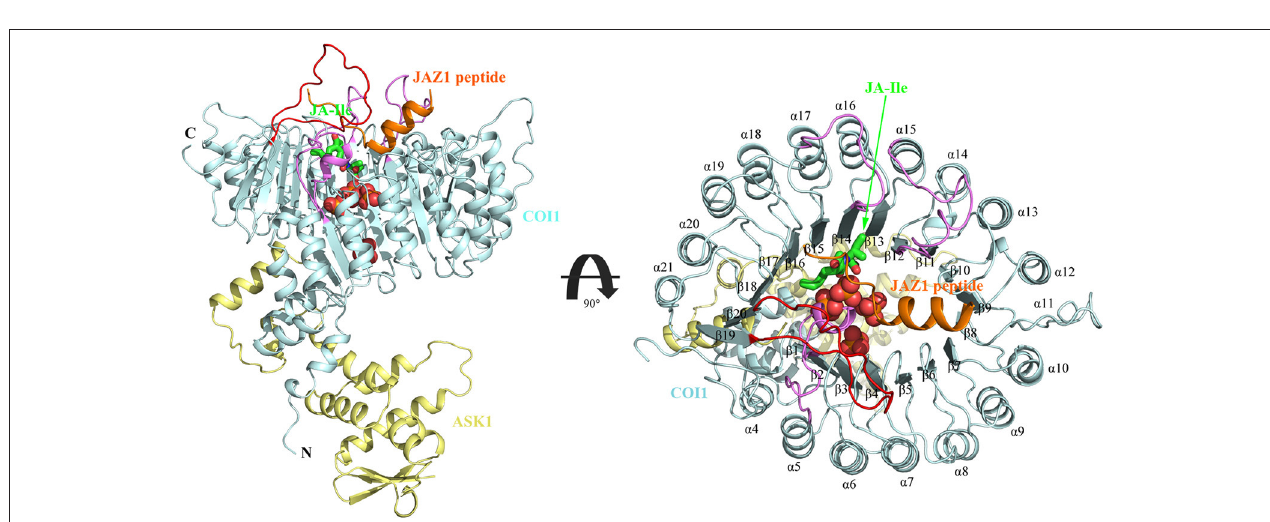
FIGURE 2 | The overall structure of the ASK1-COI1 complex with JA-Ile, inorganic phosphate molecules, and the JAZ1 degron peptide (Sheard et al., 2010). ASK1-COI1 (yellow and cyan ribbons, respectively) with the JAZ1 degron peptide (orange ribbons), inorganic phosphate molecules are depicted as spheres (orange for phosphorus atoms and red for oxygen atoms) and JA-Ile in sticks (green for carbon atoms). Loops 2, 12, and 14 are colored in pink and loop C is colored in